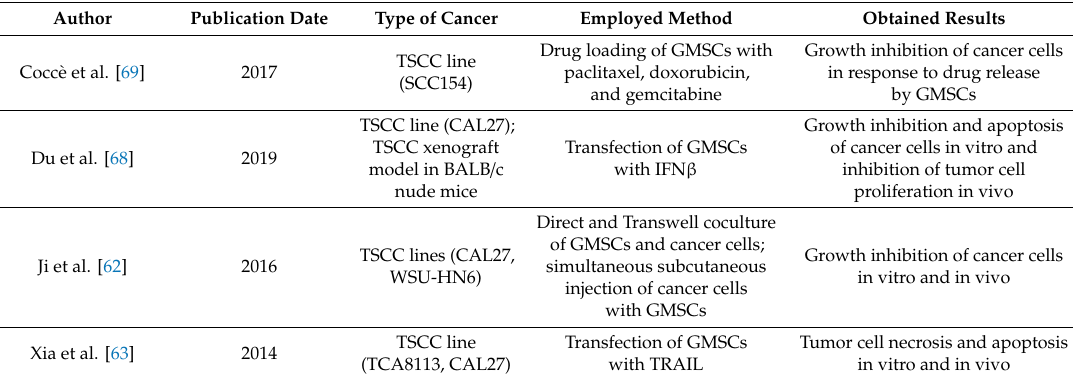
Table 2. Overview of published studies utilizing GMSCs in anticancer